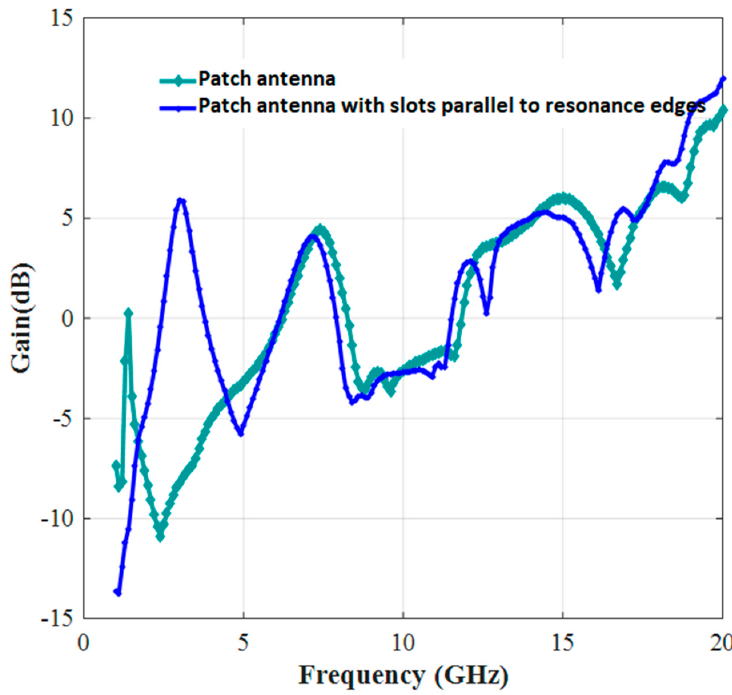
Figure 8. The gain of the patch antenna without and with slots.